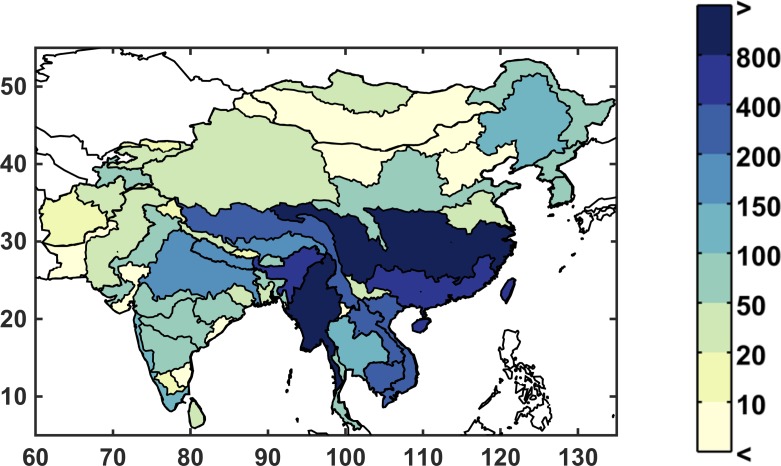
Baseline annual runoff by ASR (in billion cubic meters per year).